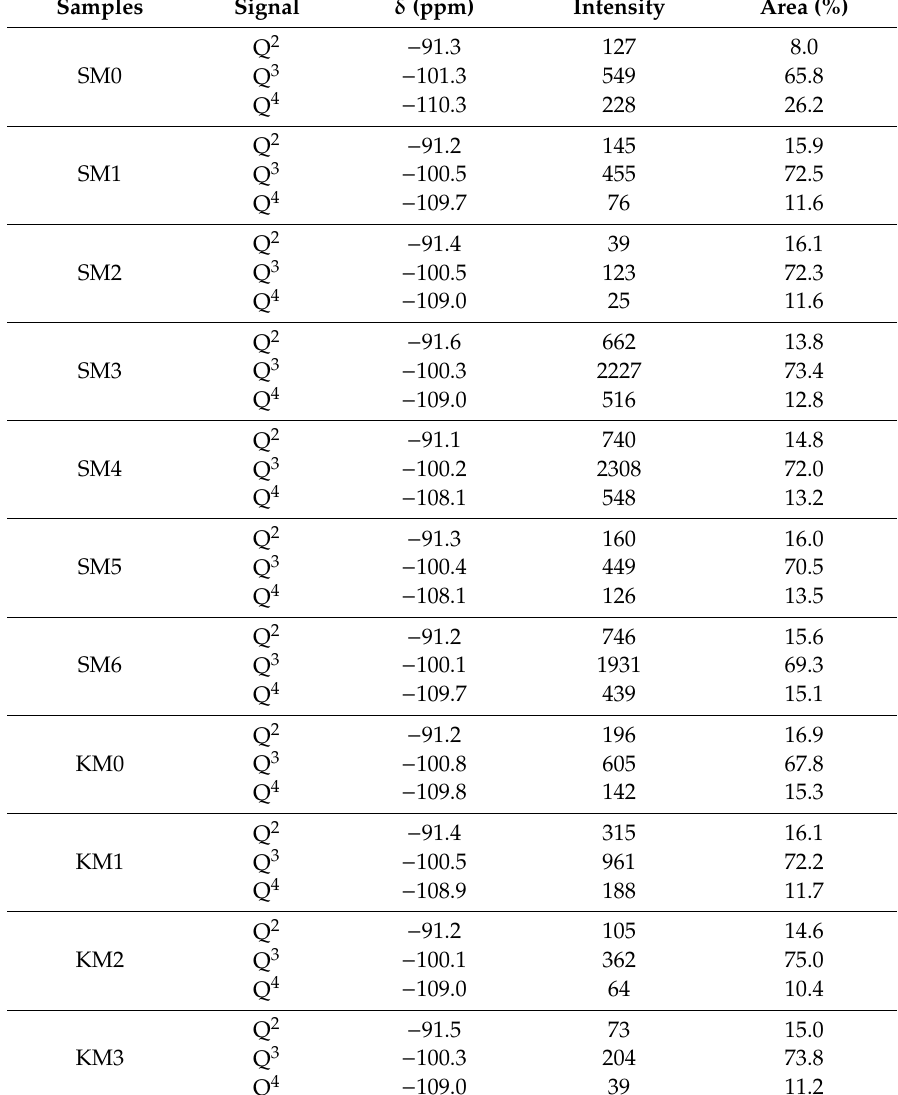
Table 5. Parameters of 1 H decoupled 29 Si solid-state MAS NMR spectra of SBA-15 and KIT-6